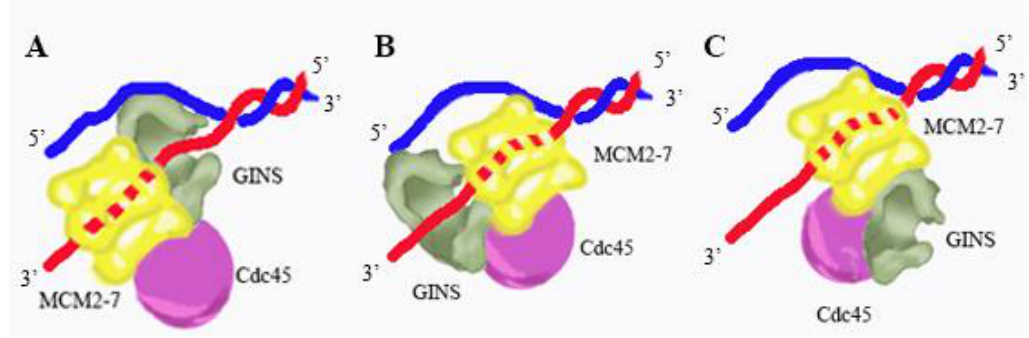
Figure 7. Model for CMG replicative helicase architecture at a fork. Three different models for CMG replicative helicase architecture at a fork are shown. In each of these models, CMG unwinds DNA by a steric exclusion mechanism. ( A ) in model A, GINS is positioned at the front of the fork, gripping single-stranded DNA and presenting the ssDNA to the Mcm2-7 ATPase; ( B ) in model B, GINS is positioned at the back of the fork, gripping leading strand DNA as it exits from the Mcm2-7 complex; and ( C ) in model C, GINS is at the side of the Mcm2-7 complex and GINS does not bind fork DNA under normal conditions. Recent electron microscopy studies suggest that Model C is relevant for a replication fork under normal conditions.